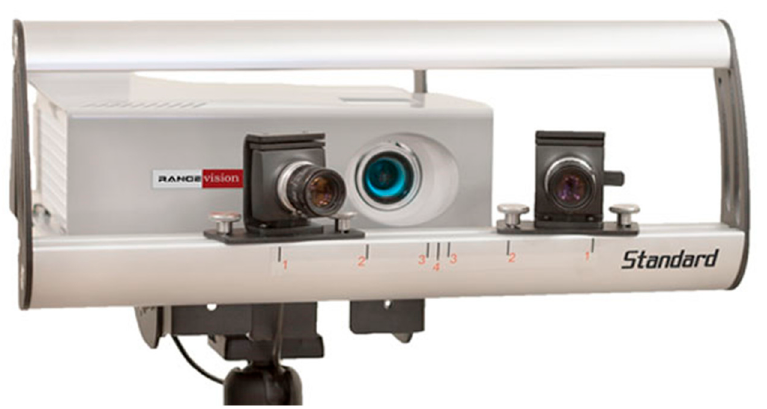
Figure 2. Three-dimensional digitizing instrument—Rangevision Professional Standard.